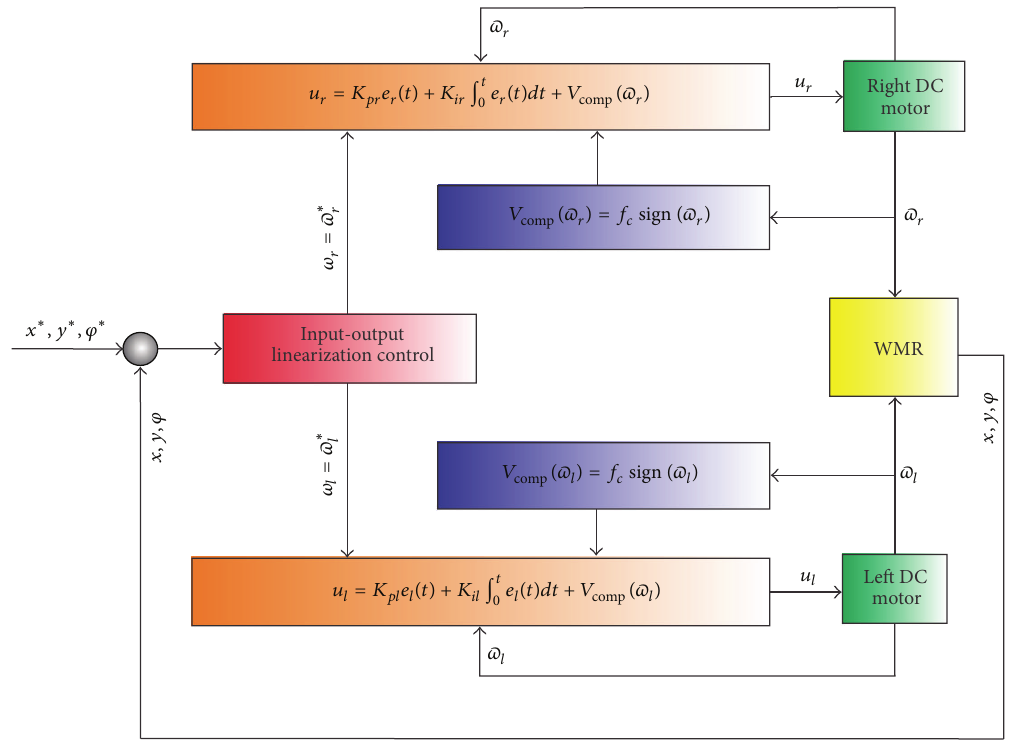
Figure 15: WMR hierarchical control block